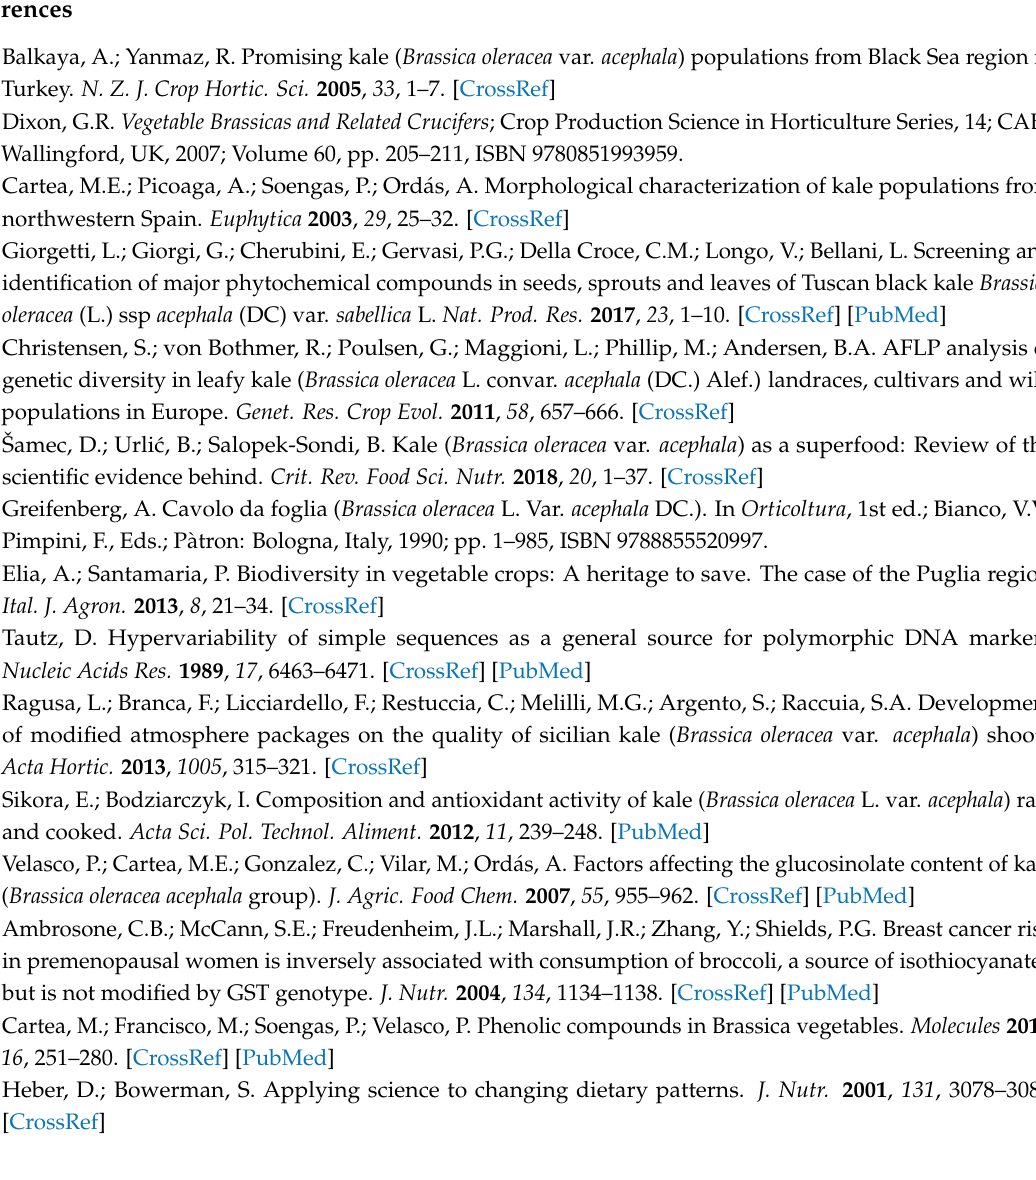
s1, Table S1: GPS coordinates and collection sites of the Apulian kale accessions characterized in this study. Table S2: Polymorphic primer pairs tested on the whole germplasm collection of Apulian kale. Asterisks indicate polymorphic primer pairs used for germplasm genetic characterization. Table S3: Pairwise population PhiPT values among Apulian kale accessions. PhiPT values are shown below diagonal. Probability values based on 999 permutations are shown above diagonal. Table S4: Fixation Index (F) among the 19 Apulian kale (AK) accessions collected in the